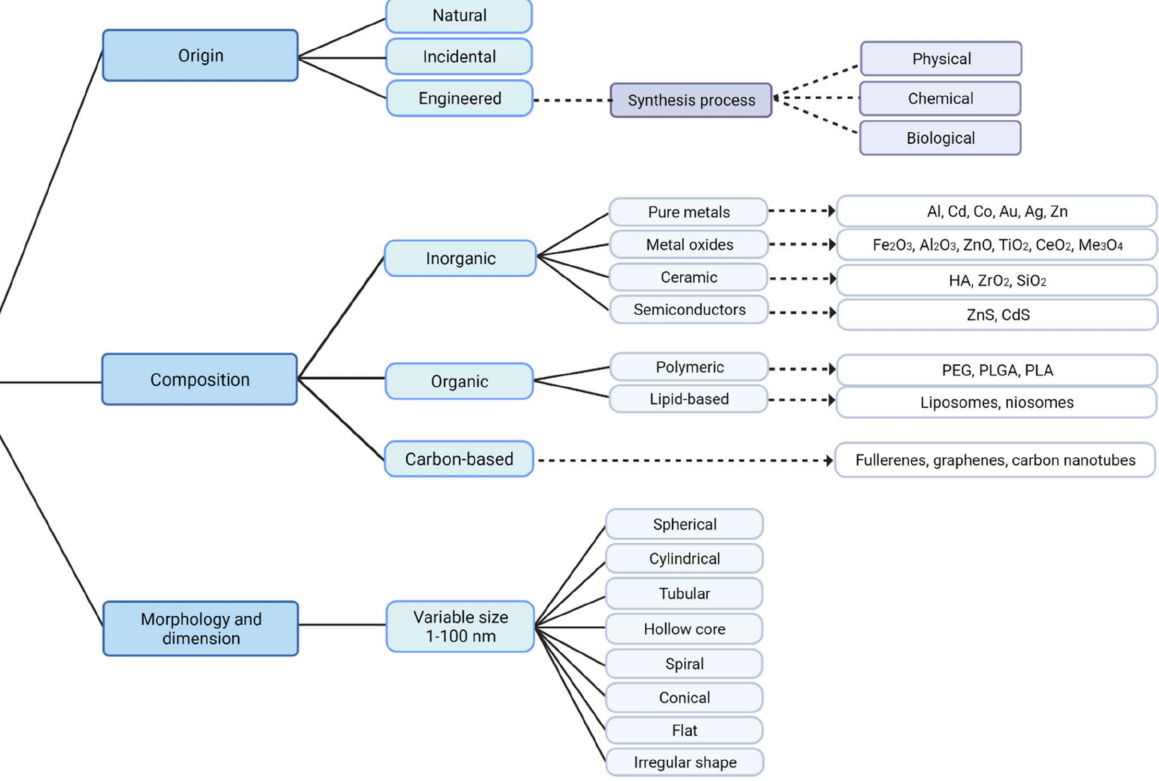
Figure 1. Classification of nanoparticles according to their origin, composition, morphology, and dimension with some examples. Metal oxide nanoparticles are engineered, inorganic nanoparticles, that can be synthesized by physical, chemical, or biological techniques, created with Biorender.com (accessed on 27 June